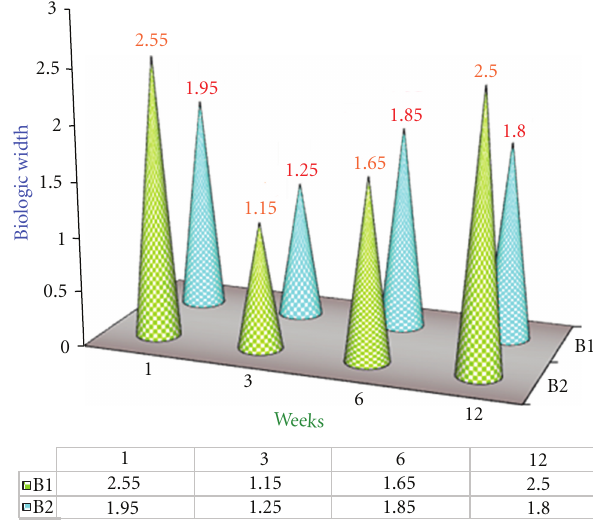
Figure 6: Comparison of mean biologic width values of B1 and B2